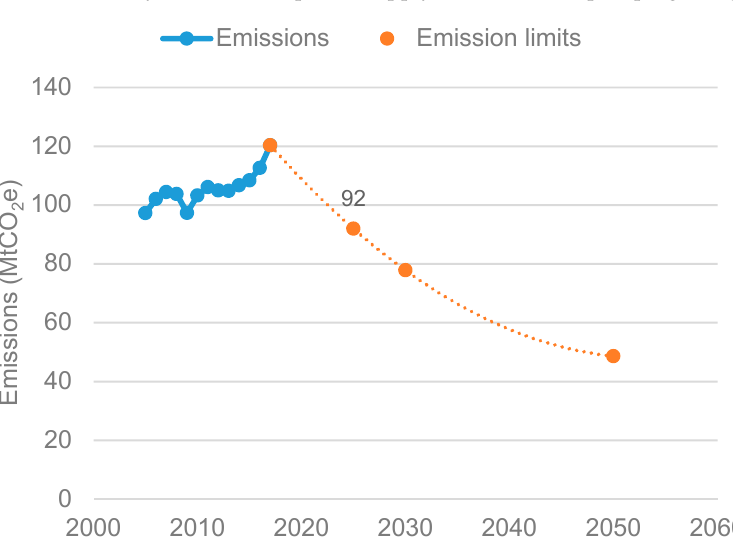
Figure 3. Carbon emissions and the reduction trajectory.